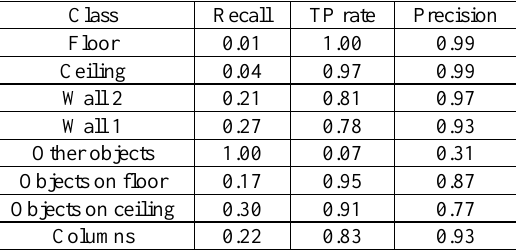
Table 1 . Accuracy metrics for the car park point cloud: Recall (false positive rate), True Positive (TP) rate and Precision.